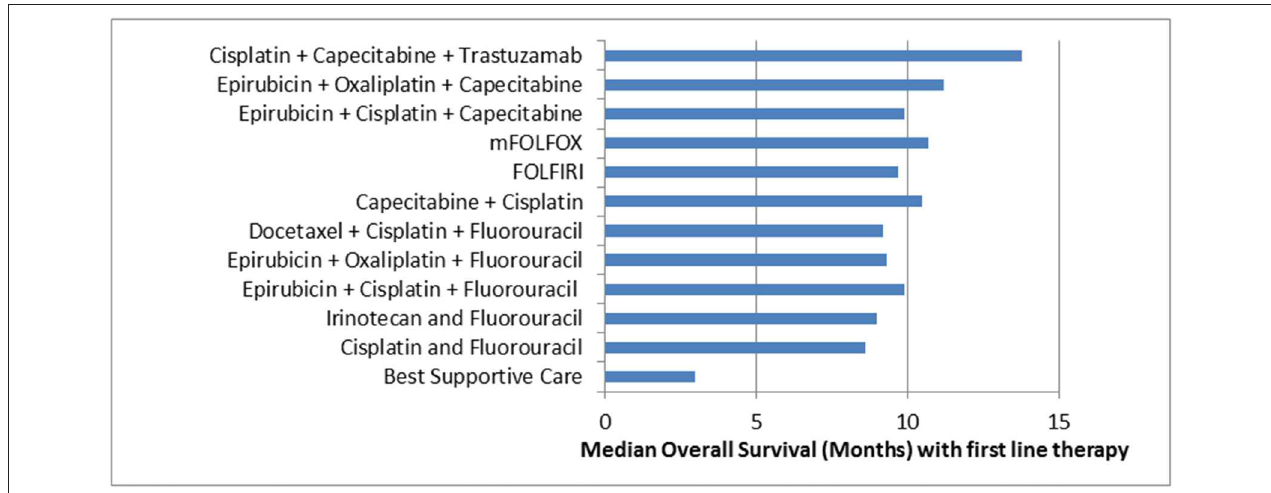
FIGURE 1 | Median Overall Survival in Advanced OG Adenocarcinoma with selected first line therapy. Cisplatin + Capecitabine + Trastuzumab (5); Epirubicin + Oxaliplatin + Capecitabine (6); Epirubicin + Cisplatin + Capecitabine (6); mFOLFOX (7); FOLFIRI (8); Capecitabine + Cisplatin (9); Docetaxel + Cisplatin + Fluorouracil ( 10); Epirubicin + Oxaliplatin + Fluorouracil (6); Epirubicin + Cisplatin + Fluorouracil (6); Irinotecan + Fluorouracil (11); Cisplatin + Fluorouracil (10); Best Supportive Care (12).